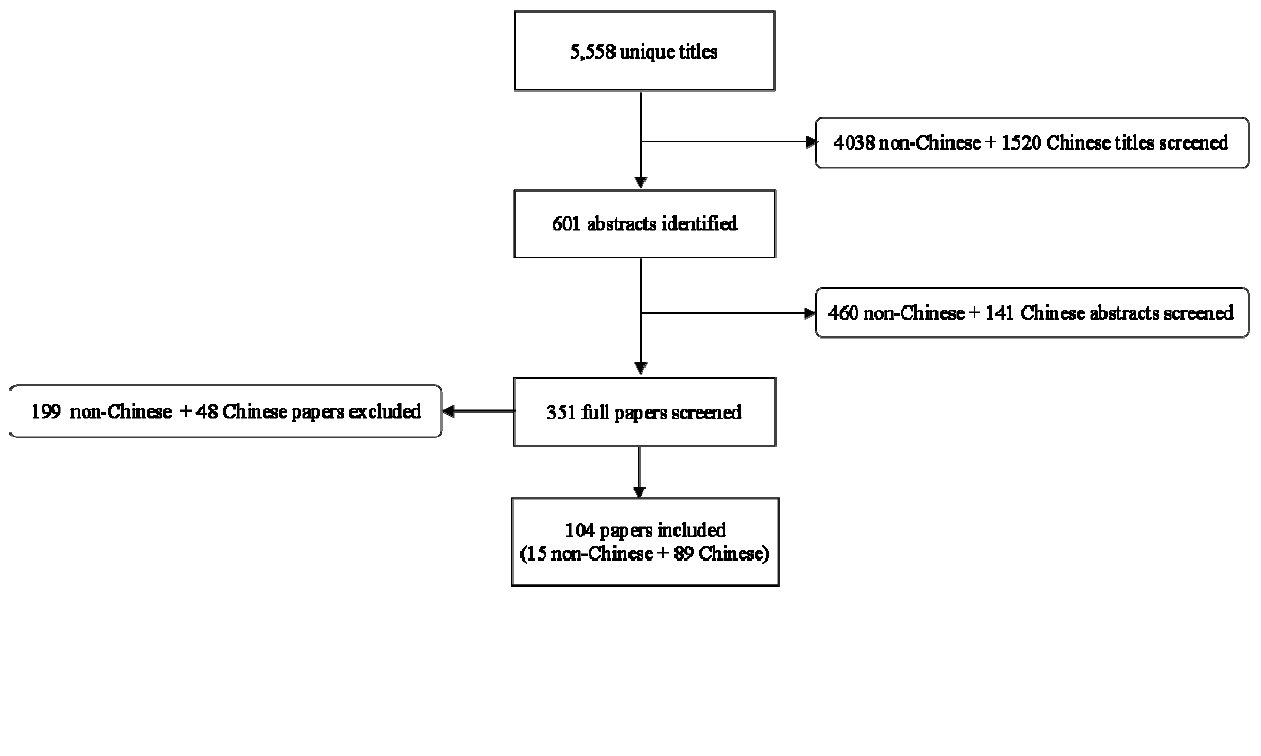
Figure 1. Results of systematic literature search and